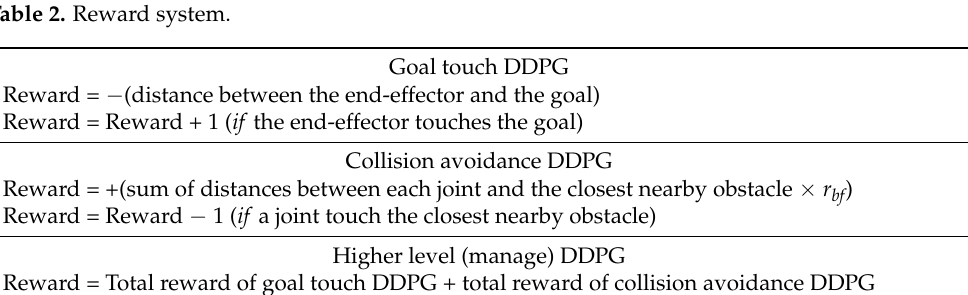
Table 2. Reward system.